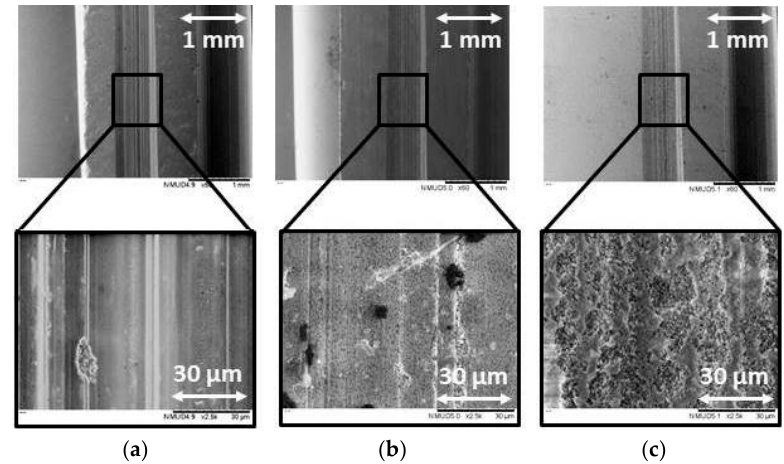
Figure 5. SEM analysis of the ground bioceramics under magnifications 60× and 2500×, i.e., for ( a ) ZrO 2 , ( b ) ATZ, and ( c ) ZTA specimens. The bioceramics were machined with process condition P8, i.e., v c = 10.00 m/s, v f = 100 mm/min, and a e = 50 μ m.